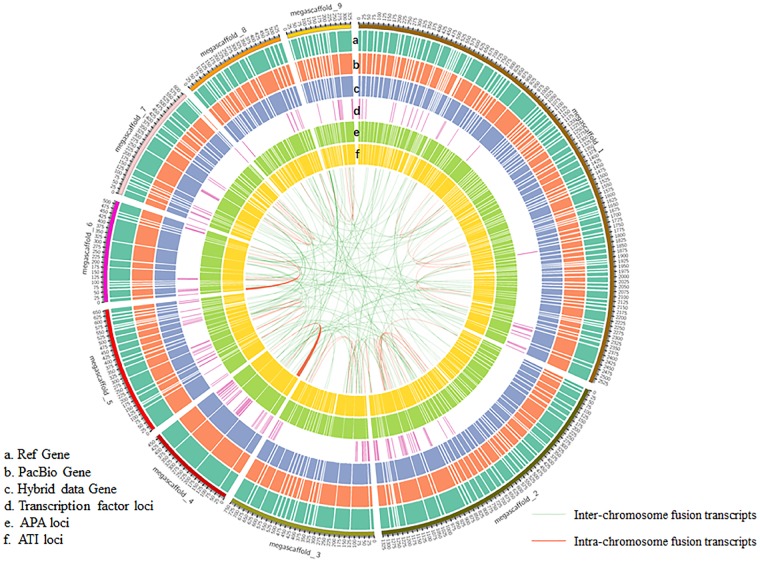
CIRCOS visualization of distribution of different data at genome-wide level. (a) Gene density of reference genome. (b) Density of the predicted genes from PacBio data. (c) Density of predicted genes from hybrid data consisting of PacBio and Illumina data. (d) Distribution of the loci of predicted TF. (e) Distribution of genes with alternative poly(A) site. (f) Distribution of genes with ATI site. Linkage of fusion transcripts was showed in the most inside, with inter- and intra-chromosome, respectively. Based on the mapping results and the distribution of the fusion transcripts, only the biggest nine megascaffolds were shown here.